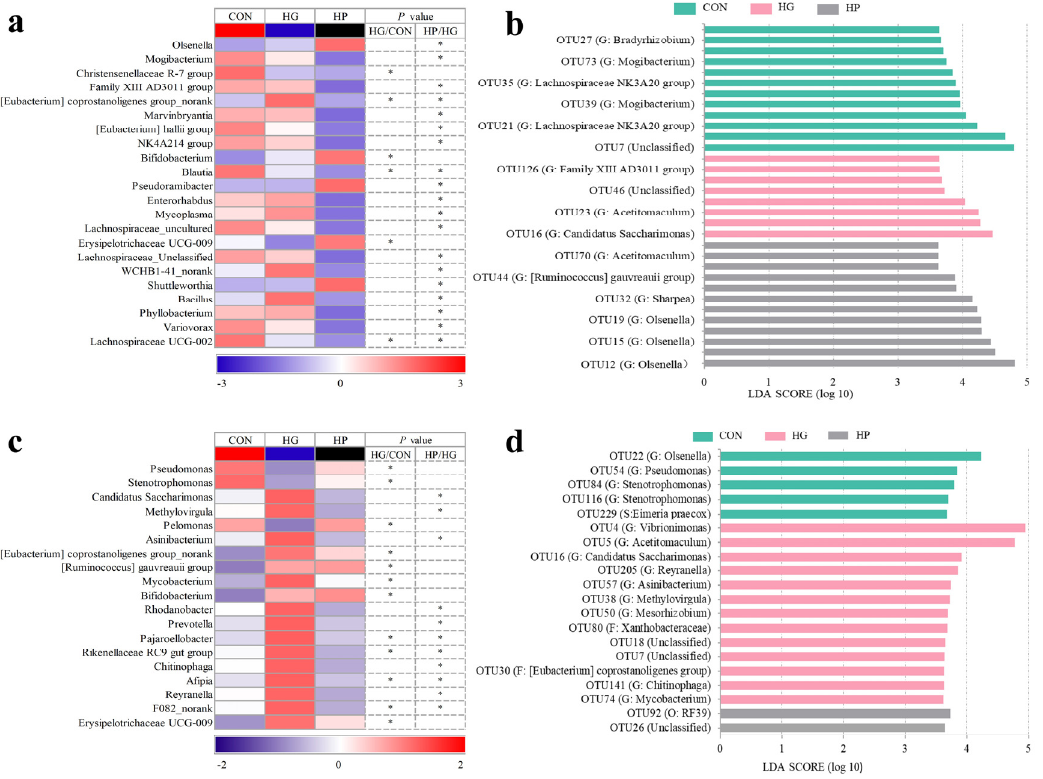
Figure 3. Statistical analysis of jejunal digesta − and mucosa − associated microbiota at the genus ( a , c ) and OTU ( b , d ) levels in Hu sheep (n = 5) fed the CON, HG, and HP diets. CON, the control